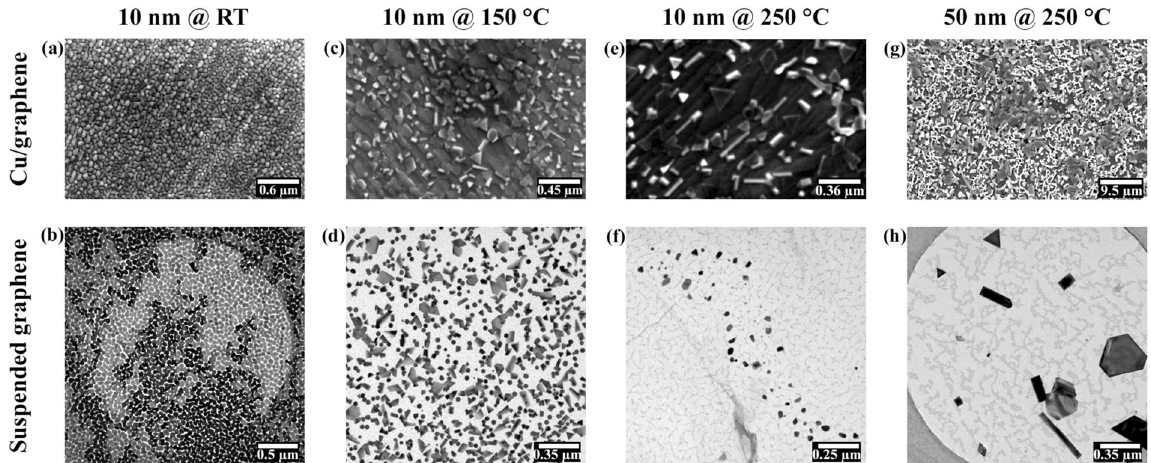
Fig. 5 Growth parameter space. Sb deposits on Cu-supported graphene (SEM in a , c , e , g ) and suspended graphene (BF-TEM in b , d , f , h ) deposited at nominal thicknesses of 10 nm at RT ( a , b ), 150 °C ( c , d ), and 250 °C ( e , f ) and 50 nm at 250 °C ( g , h ), respectively. e is replotted from Fig.